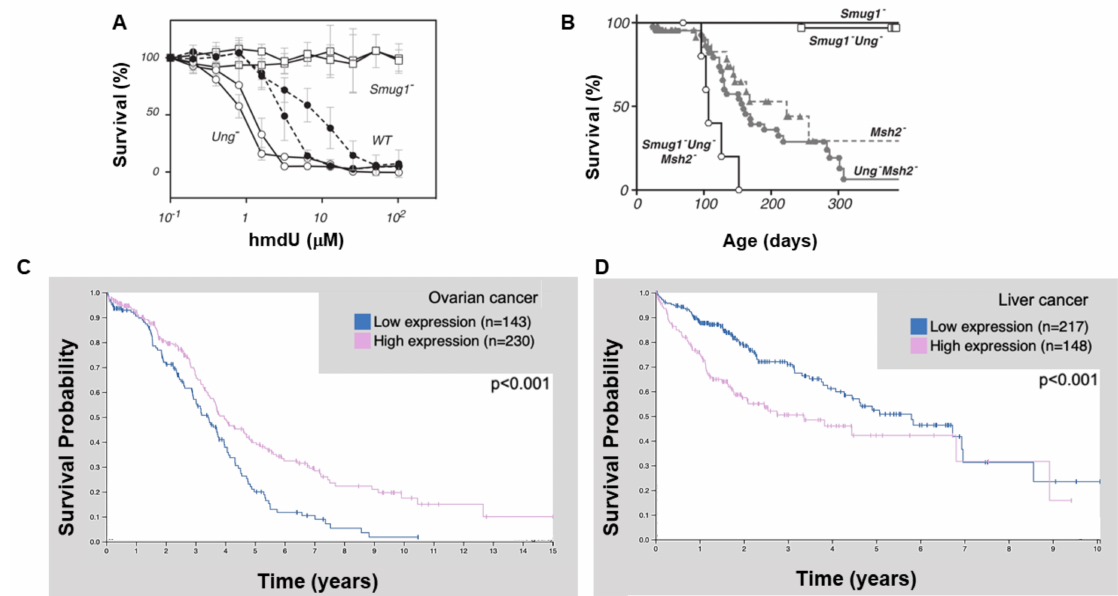
Figure 5. SMUG1 and cancer development and progression. The relationship between SMUG1 expression and cancer progression. ( A ) Effects of Smug1 − / − Ung − / − Msh2 − / − on mice survival from [45] with permission. ( B ) Smug1 − / − has protective effect to treatment with 5-hmdU, from with [45] permission. Summary of the search of The Human Protein Atlas for SMUG1 in the pathology section. Prognostic analysis of patient survival in ( C ) ovarian and ( D ) liver cancers. Low mRNA expression (blue) compared to high (pink) mRNA expression levels of SMUG1, analysis reached high significance